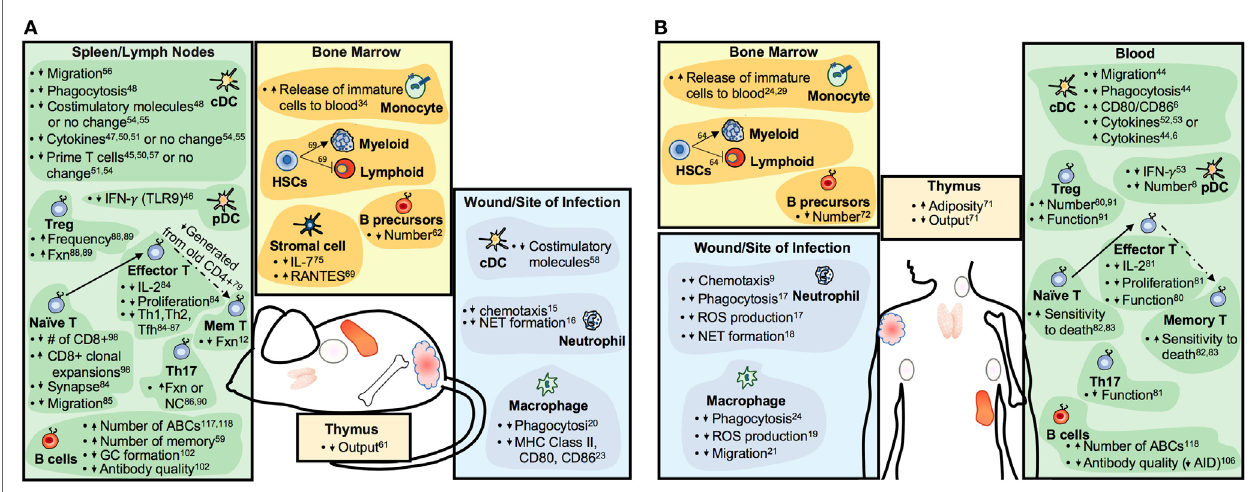
FigURe 1 | Summary of aging-related changes to the immune systems of mice (A) and humans (B) . Increases or decreases in cell numbers or particular functions are indicated by upward- or downward-pointing arrows, respectively. Abbreviations: Fxn, function; GC, germinal center; Mem, memory; ABC, age-associated B cell; NC, no